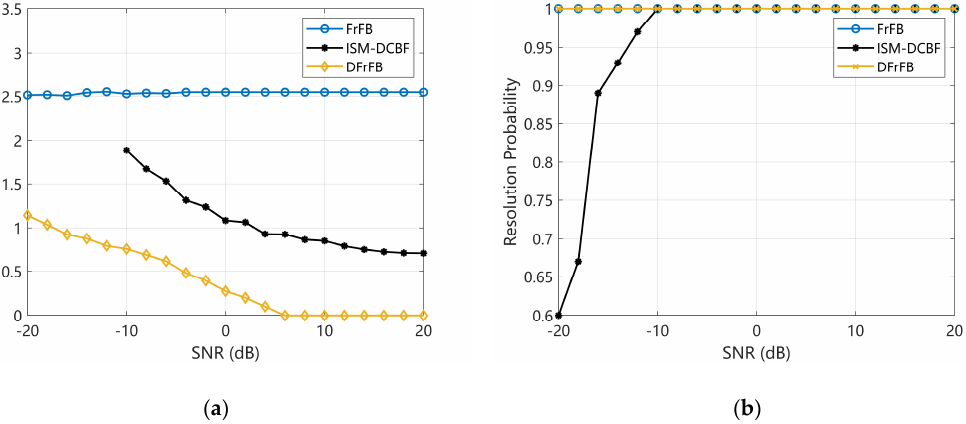
Figure 4. The performances of FrFB, ISM-DCBF, and DFrFB versus the SNR of the received signal. ( a ) The RMSE; ( b ) the RP.